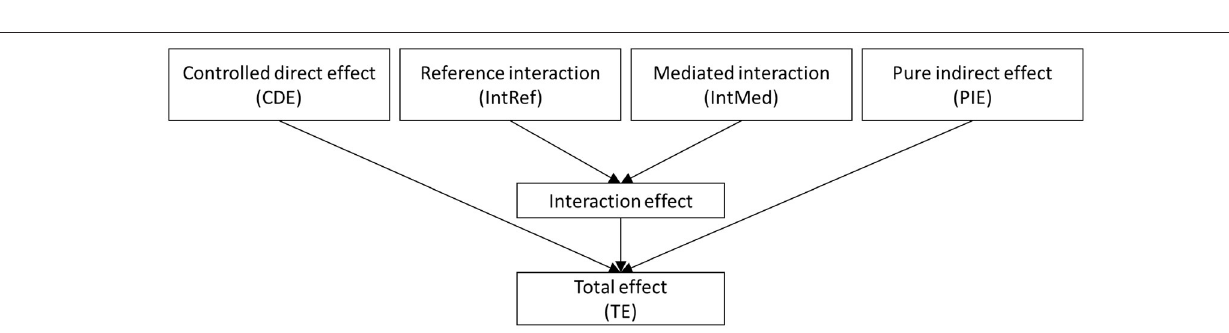
FIGURE 2 | The four-way decomposition method encompasses both the components for mediation and